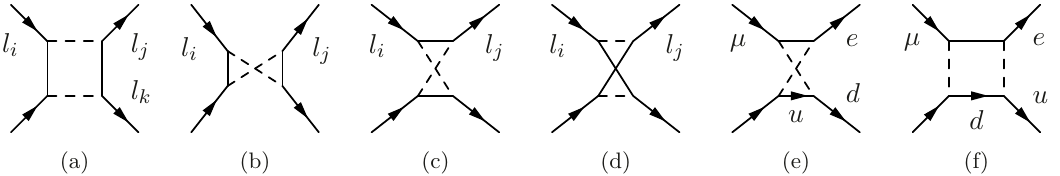
Figure 5. Box contribution. The first two four-lepton diagrams from the left are proportional to m 2 D 0 , the last two of them — to 2 D 00 . Arrows represent the propagation of particles; scalar and 4 fermion lines in the loops correspond to H − and ν ′′